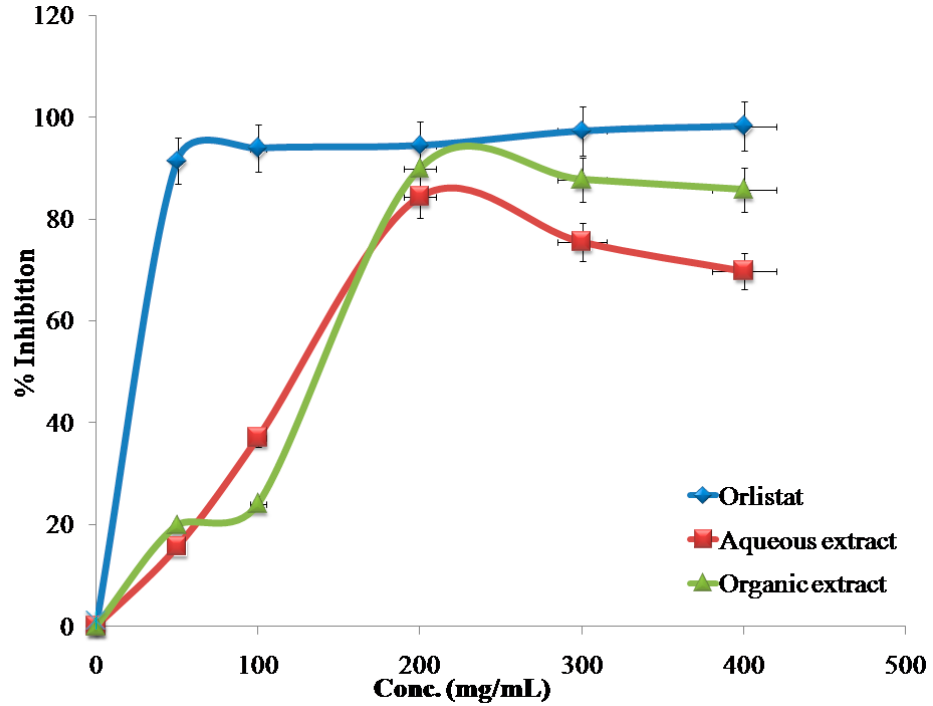
Figure 6. The inhibitory effects of the aqueous and organic extracts of P. guajava and Orlistat on the activity of porcine pancreatic lipase.